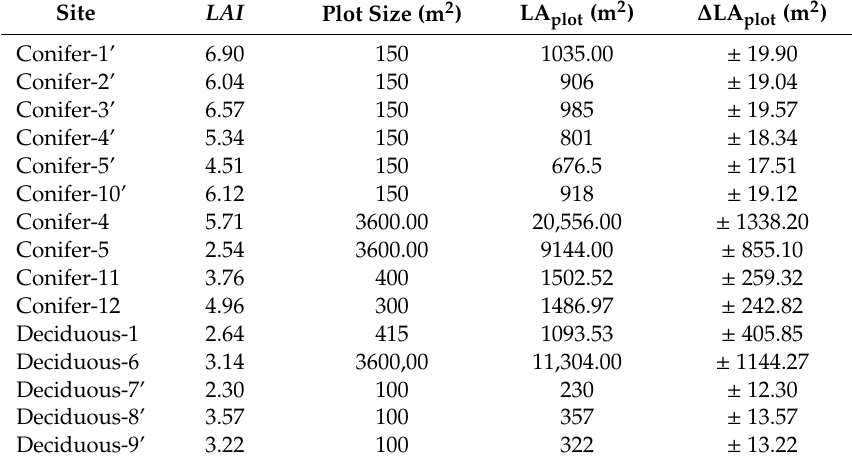
Table 4. Leaf Area Index (LAI) and estimated LA plot according to stand size where ∆ LA plot is the absolute error associated with LA plot . The error propagation estimation is detailed in Section 3.3. Prime symbol indicates 10 × 10 m stands. No prime symbol indicates 60 × 60 m stands. Site LAI Plot Size (m 2 ) LA plot (m 2 ) ∆ LA plot (m 2